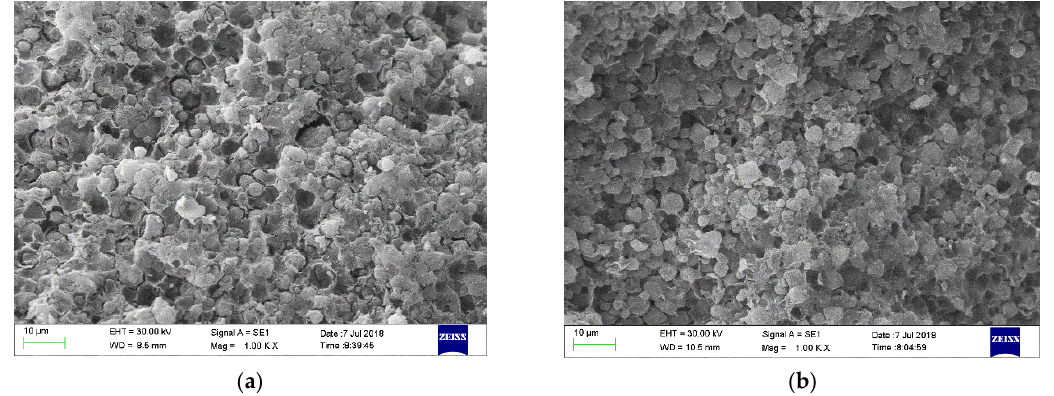
Figure 4. SEM image of the CTS-ZMS samples before and after ammonium nitrogen adsorption: ( a ) CTS-ZMS ( × 1000), ( b ) ammonium nitrogen adsorbed CTS-ZMS ( × 1000).